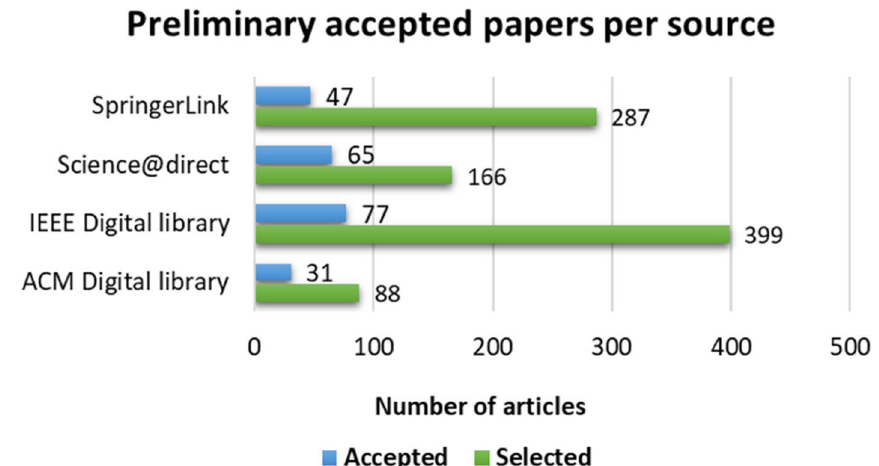
Fig. 9 Selected and preliminary accepted papers per